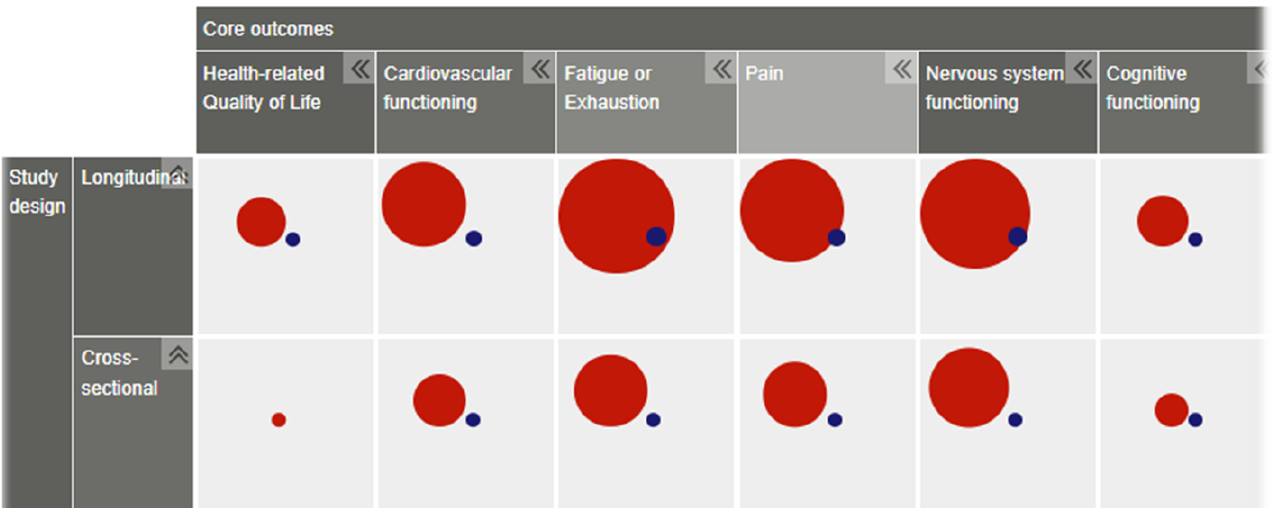
Figure 3. Screenshot (fragment) of an evidence map sorted out by study design, outcomes, and subgroup of adults (red) or children (blue).